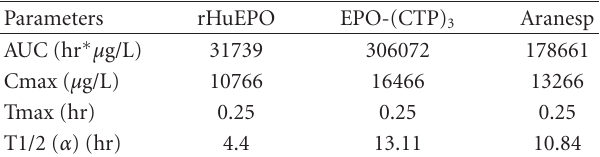
Table 2: Mean pharmacokinetic parameters following IV admin- istration of a single dose (20 μ g/kg) of rHuEPO, EPO-(CTP) 3 , and Aranesp in male ICR mice. Parameters were generated for individual rats and the mean data are presented here. Parameters